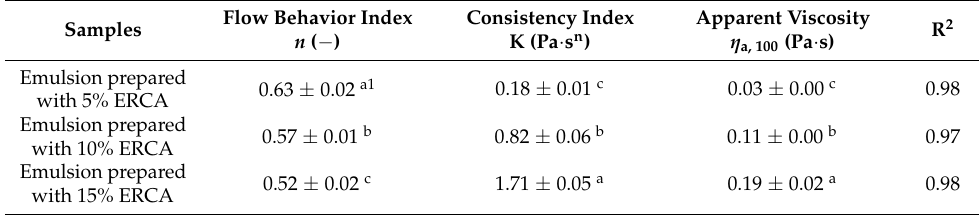
Figure 1. Shear stress vs. shear rate for emulsion prepared with different concentrations of esterified rice flour with citric acid (ERCA). ( (cid:51) Table 1. Steady shear rheological properties of emulsion prepared with different concentrations of esterified rice flour with citric acid